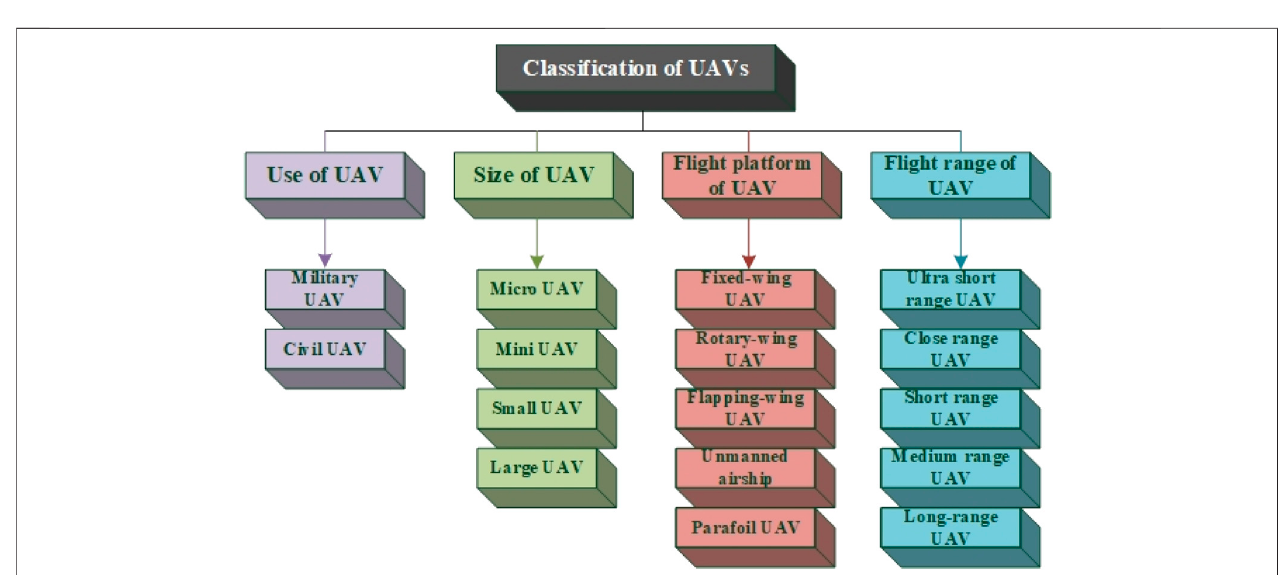
FIGURE 2 | Classi fi cation of UAVs.